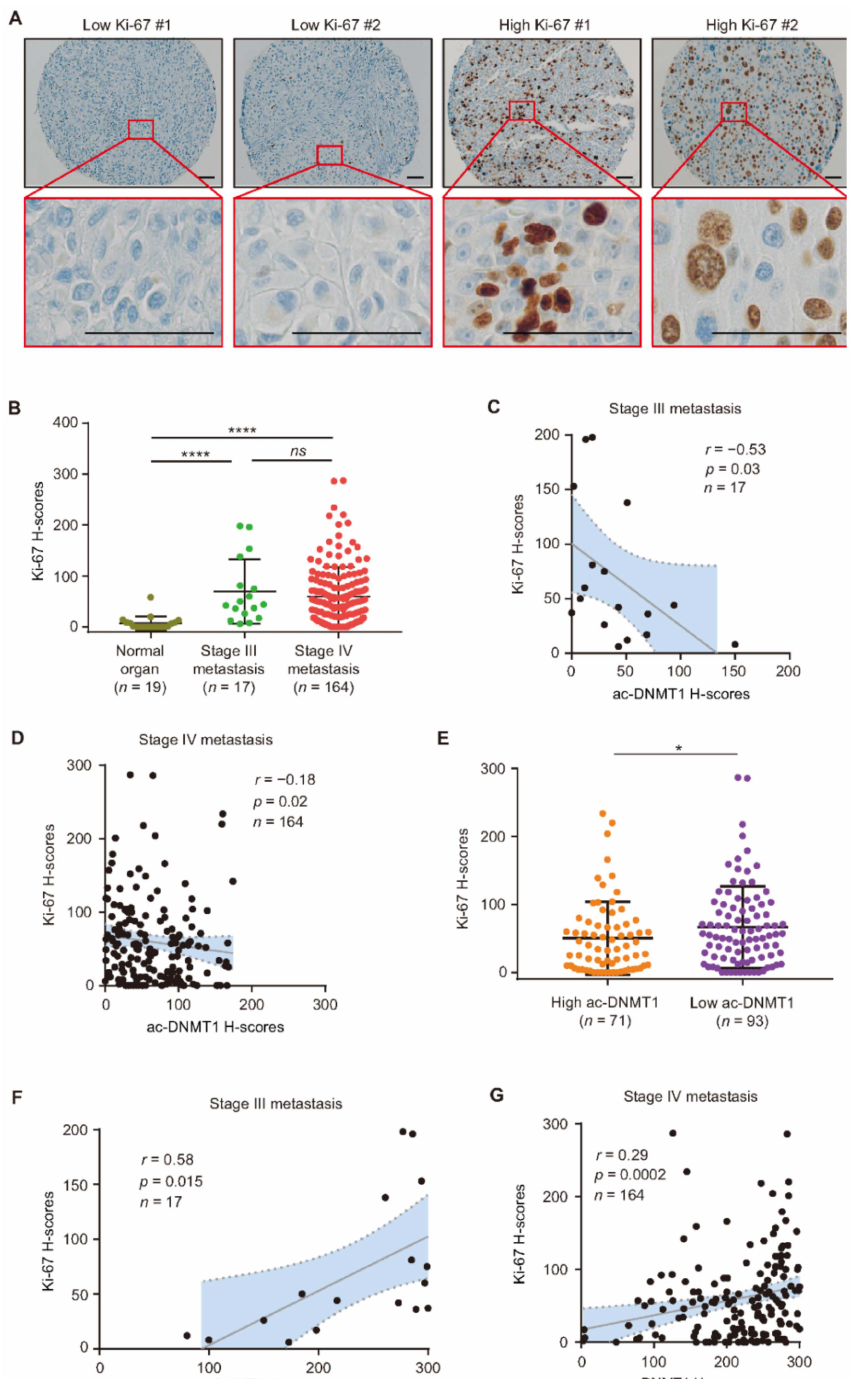
Figure 6. Ac-DNMT1 and Ki-67 protein levels correlate in metastatic melanoma. ( A , B ) Representative IHC images and H-score quantification of Ki-67 in normal organ tissues, stage III, and stage IV metastatic melanomas from the TMA cohort. Scale bars = 20 µ m. ( C , D ) Correlation between Ki-67 and ac-DNMT1 H-scores in stage III ( C ) or stage IV ( D ) metastatic FFPE tissues. ( E ) Comparison of Ki-67 H-scores in stage IV patients with high or low ac-DNMT1 levels. ( F , G ) Correlation between Ki-67 and DNMT1 IHC H-scores in stage III ( F ) or stage IV ( G ) metastatic FFPE tissues. The best-fit line (straight line) and the 95% CI (dotted line) are shown in grey. Data represent the mean ± SD. ns : not significant, * p < 0.05, and **** p <